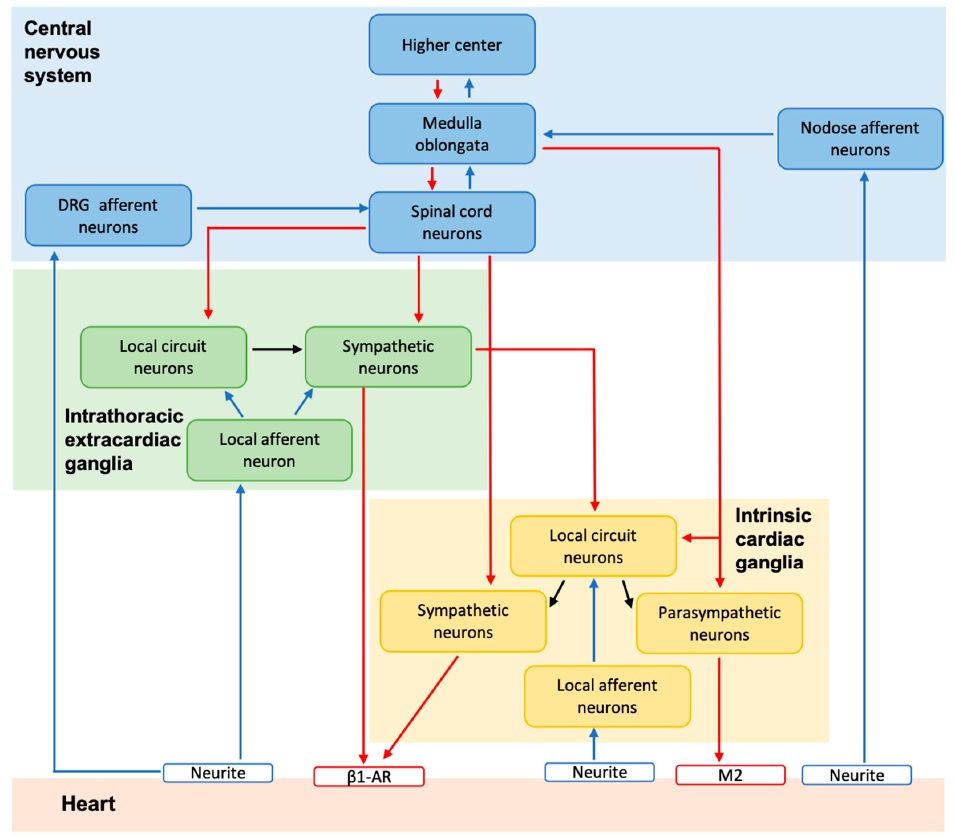
Figure 1. Model of the hierarchical control of the heart by the cardiac autonomic nervous system (CANS). The intrinsic cardiac nervous system (ICNS) contains efferent (parasympathetic and sympathetic) neurons, local afferent neurons and local circuit neurons. The intrathoracic extracardiac ganglia (stellate ganglia and middle cervical ganglia) contain sympathetic neurons, local afferent and local circuit neurons. The intrathoracic ganglia (intra- and extracardiac) work in close coordination as a nested loop, which is further tuned by the CNS (spinal cord, brainstem, hypothalamus, and forebrain) resulting in the regulation of cardiac function on a beat-to-beat basis. DRG: dorsal root ganglion; β 1AR: beta 1 adrenergic receptor, M2: muscarinic acetylcholine receptor type 2. Neurite: local afferent neurites embedded in the cardiac walls. Figure adapted from Ardell & Armour J. Phys published by Wiley 2016 [2].